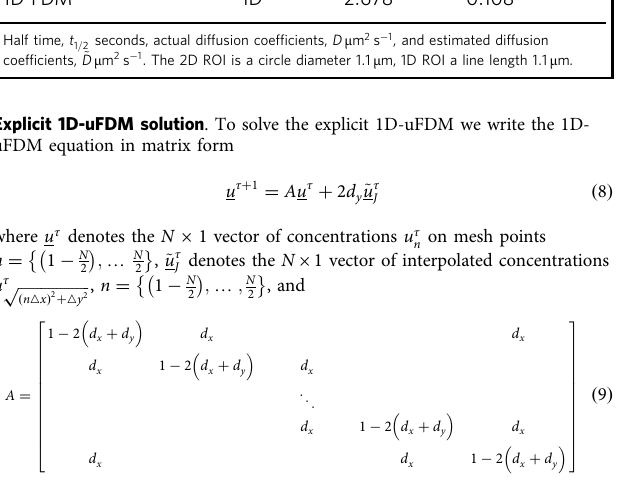
a tridiagonal N × N matrix, with periodic boundary conditions. Using interpolation